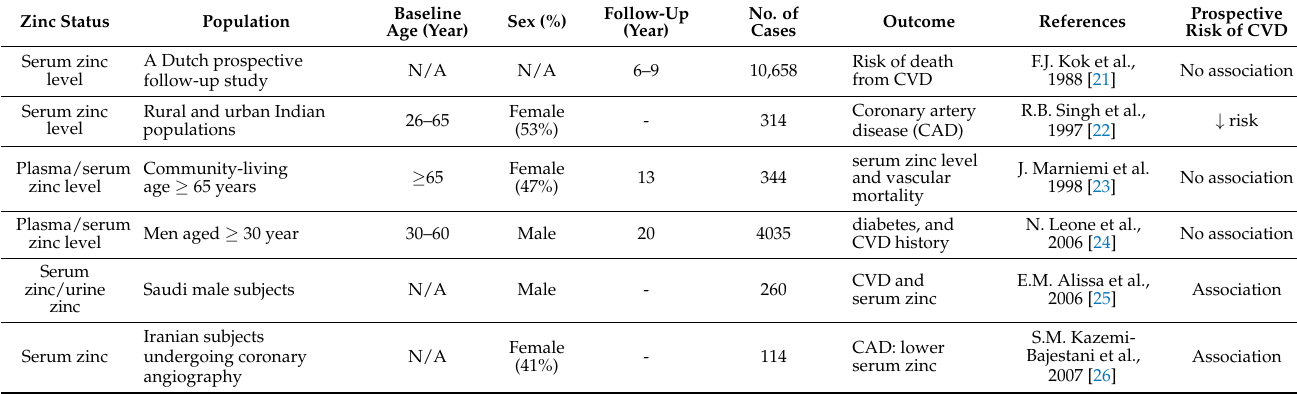
Table 2. Epidemiological studies of the relationship between zinc level and the risk of